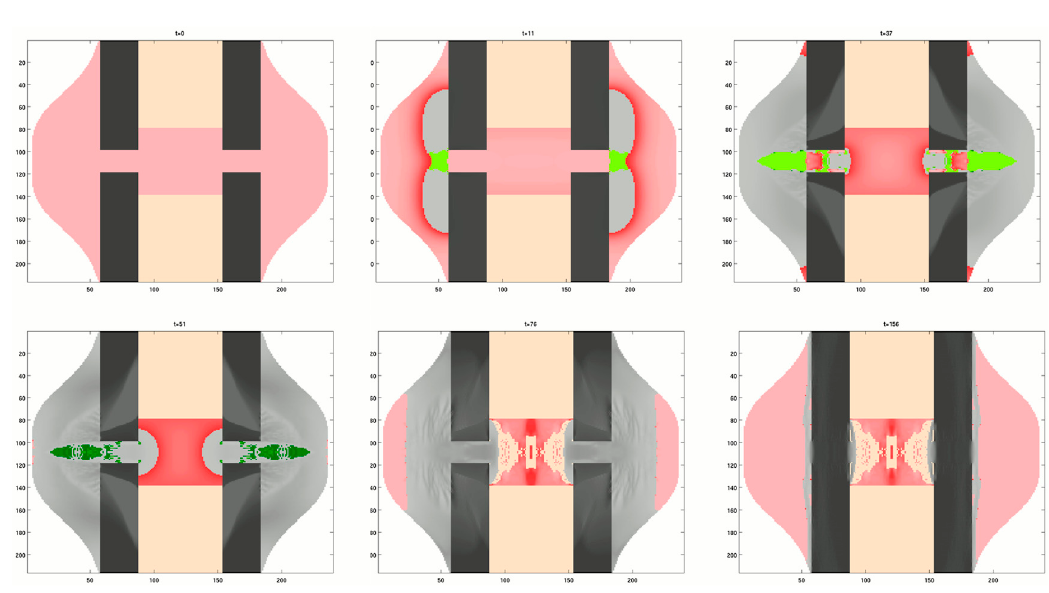
Figure 4. Six snapshots of a computer model showing the time evolution of different tissues during bone healing. The succession of images should be read from left to right starting with the top row. A top/bottom and left/right symmetry is assumed in the model. The starting configuration shows the disconnected cortical bone (black) surrounded by a callus of soft tissue (red) and bone marrow (orange). During the course of healing cartilage is formed (green) within the callus. Darker shades of the same color denote more mature tissue. In the case of bone, darker grey refers to a bone of higher mass density.